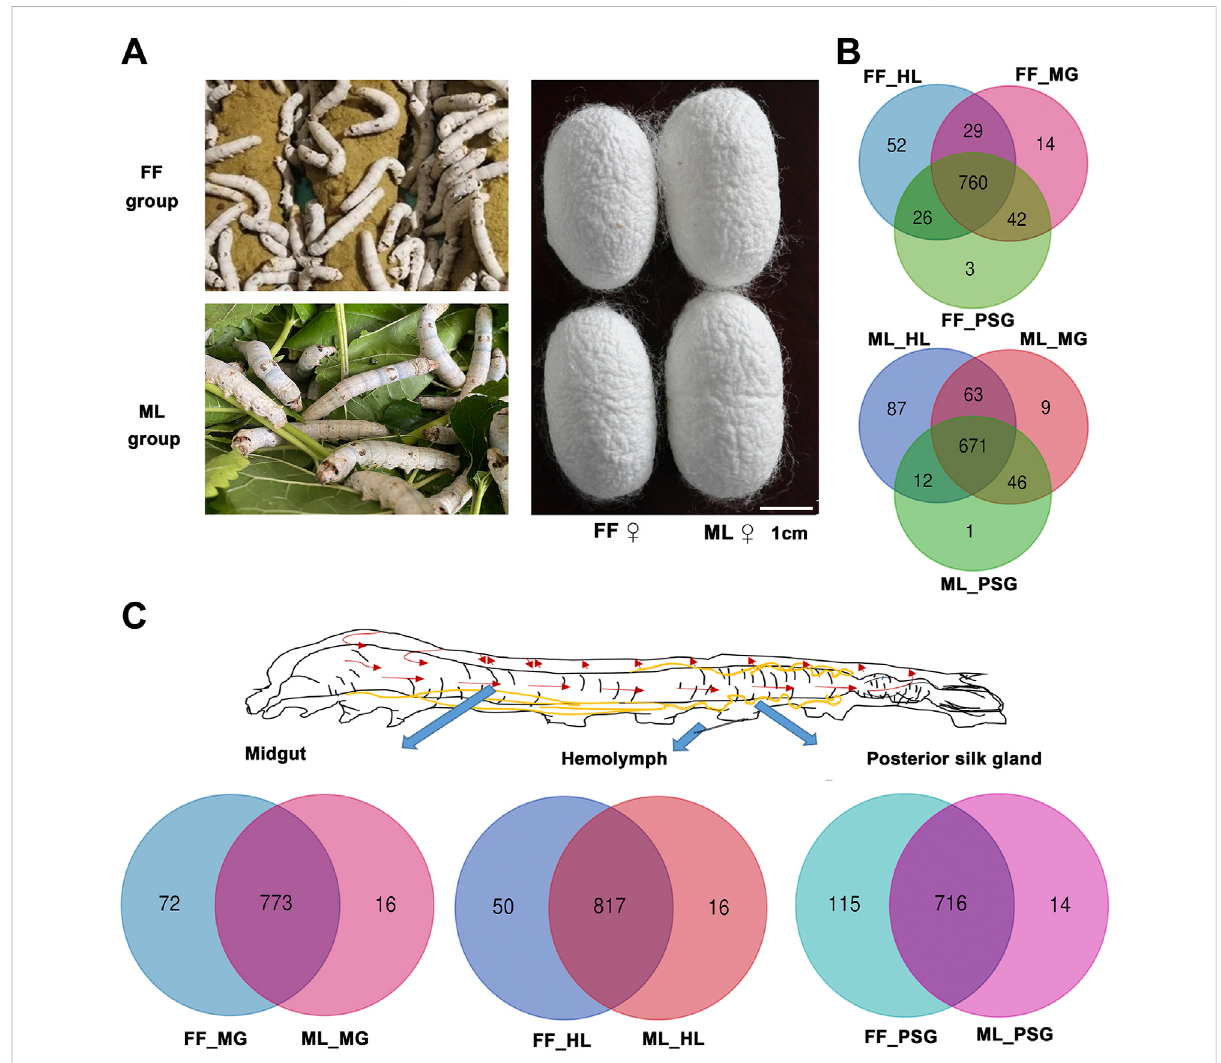
Metabolitesdistributioninthehemolymph(HL),midgut(MG)andposteriorsilkgland(PSG)betweentheFFandMLsilkworms. (A) Silkwormsfed formula feed (FF)or mulberry leaves(ML),and corresponding cocoons. (B) Metabolites distributionamongthree tissues intheFF (up) and ML (down) silkworms. (C) Unique and mutual metabolites identi fi ed in different tissues in the FF and ML